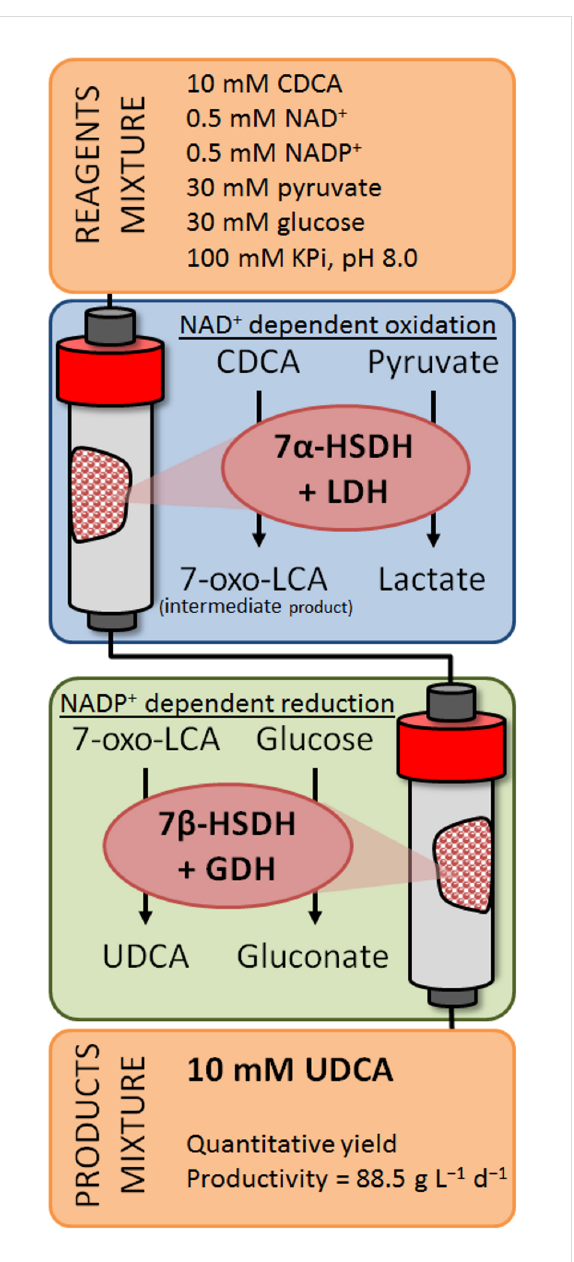
Figure 7: Schematic representation of the flow reactor for the continu- ous conversion of CDCA to UDCA